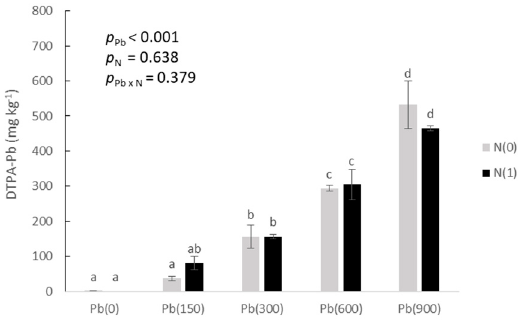
Figure 1. Pb concentration in soil extracted with DTPA as affected by the addition of Pb (0, 150, 300, 600, and 900 mg kg − 1 soil) and with (N1) and without added nitrogen (N0). Different letters above each bar denote significantly different treatments at p < 0.05. Table 2. Plant parameters in the purslane cultivated in soil with added Pb with and without N.